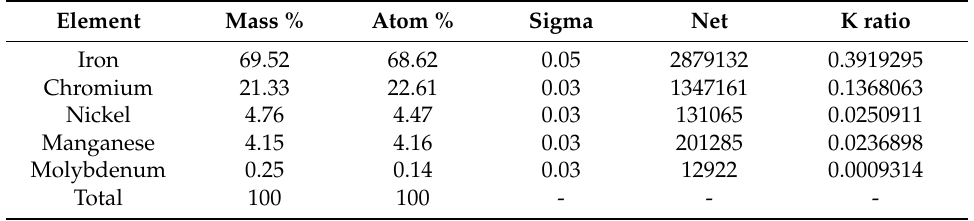
Figure 5. EDS elemental analysis, where ( a ) is the SEM image and its elemental maps of the characterised 150 nm deposited SS film at 0.05 Å/s on Cu substrate, and ( b ) demonstrates the EDS X-ray spectrum of the elements within the film shown in ( a ). Table 2. EDS elemental composition percentage of the 150 nm SS fabricated film at 0.05 Å/s controlled deposition rate.